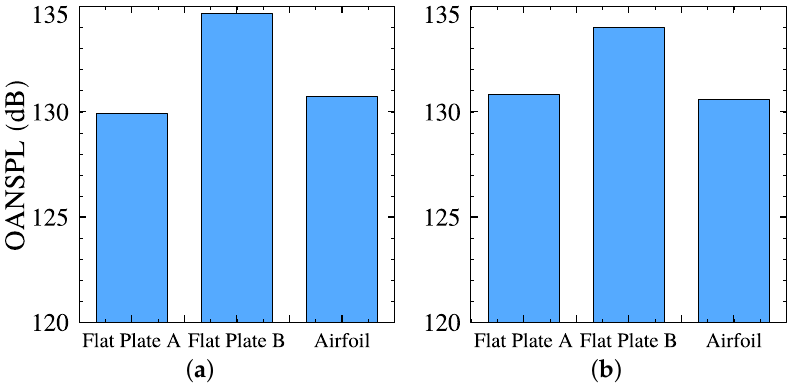
Figure 4. Overall NSPL at the inlet, ( a ) and outlet, ( b ), for the three modelling approaches